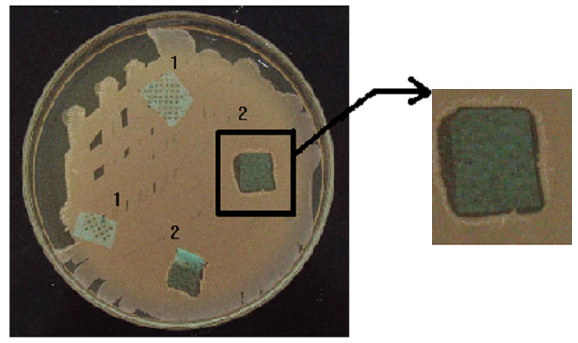
Figure 9: Antimicrobial testing of PPNW coated with chitosan against Bacillus subtilis , 1- PPNW, 2- PPNW with chitosan